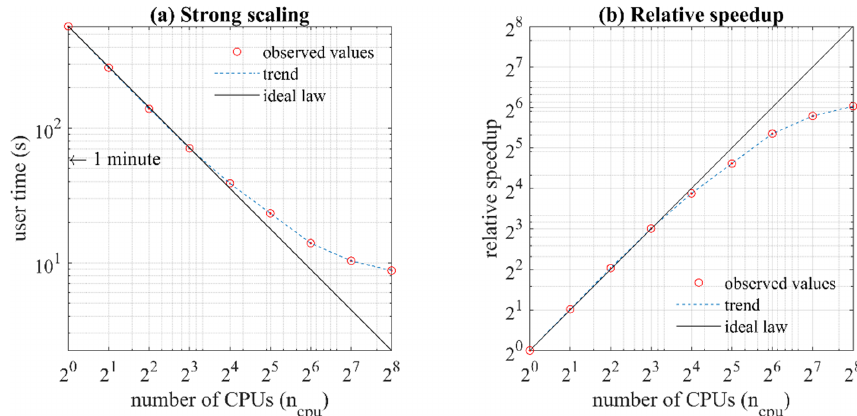
Figure D1. Strong scaling (a) , relative speedup (b) , and number of elements per CPU plots for a number of CPUs equal to 1, 2, 4, 8, 16, 32, 64, 128, 256, and 512. The line marked “ideal law” indicates perfect scalability for the tests that were